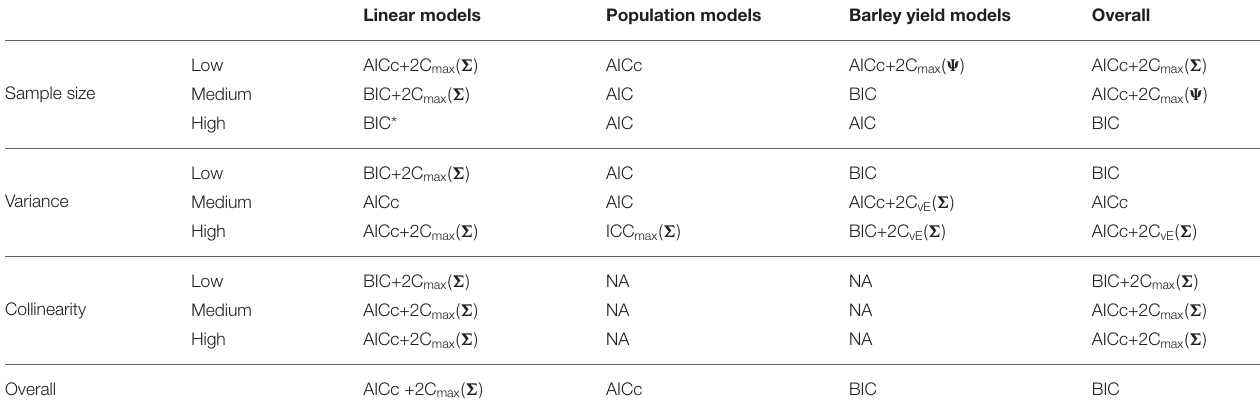
TABLE 6 | Best performing information criteria at selecting the minimum KL divergence from the candidate